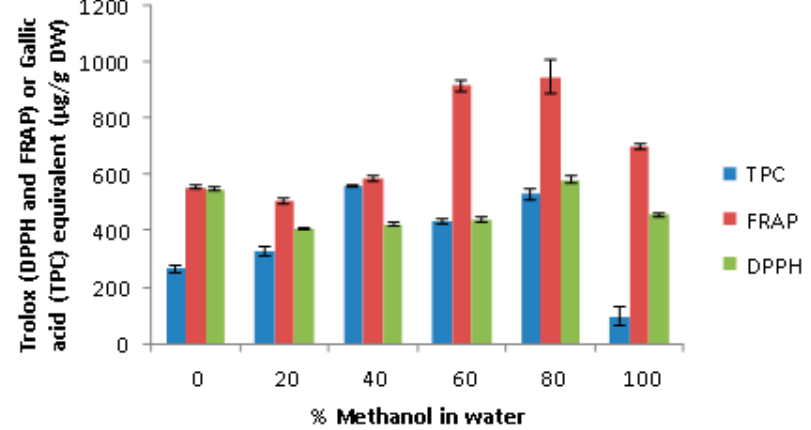
Figure 2. Effect of different methanolic compositions on the antioxidant activity (2,2-diphenyl-1-picrylhydrazyl (DPPH) and ferric reducing antioxidant power (FRAP)) and total phenol content (TPC) of the yellow onion extract.